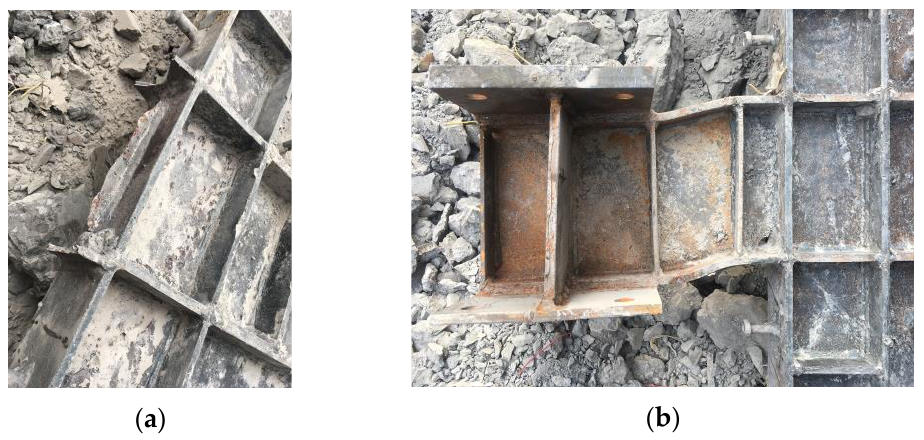
Figure 14. Significant shear deformation of SCBs. ( a ) CS-1; ( b ) CS-2.